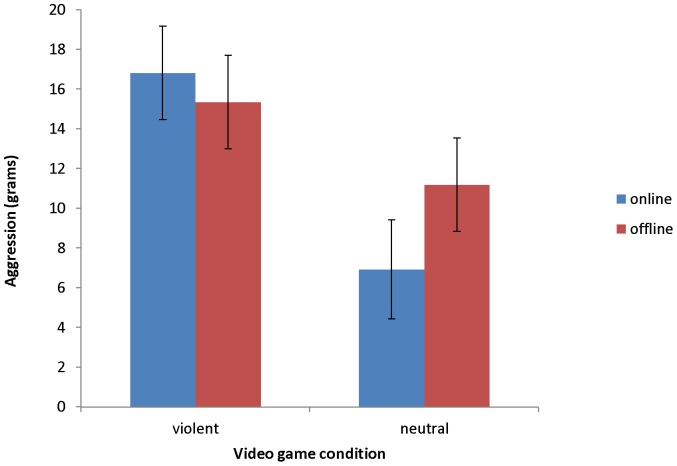
Mean grams of chilli sauce by experimental condition.